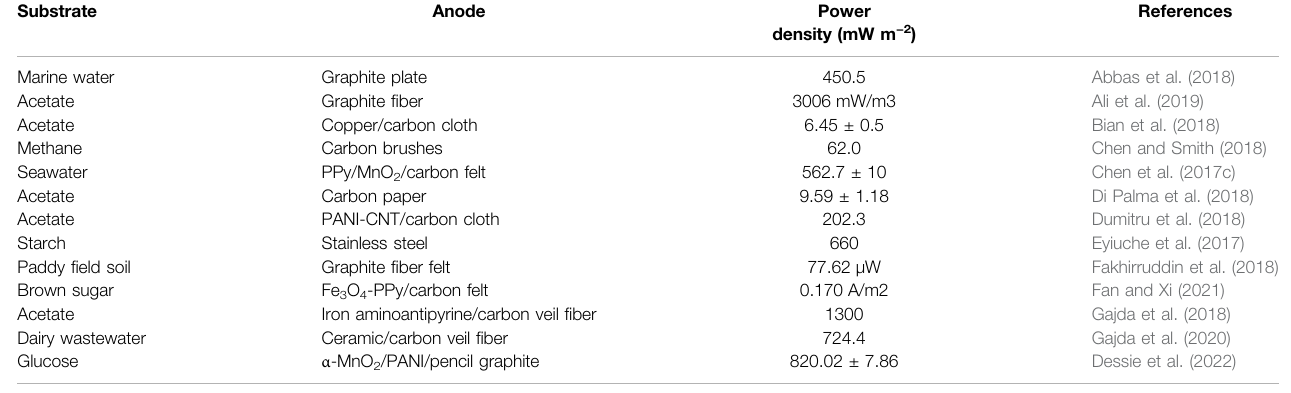
TABLE 1 | Power density performances using different electrodes in an MFC system. Substrate